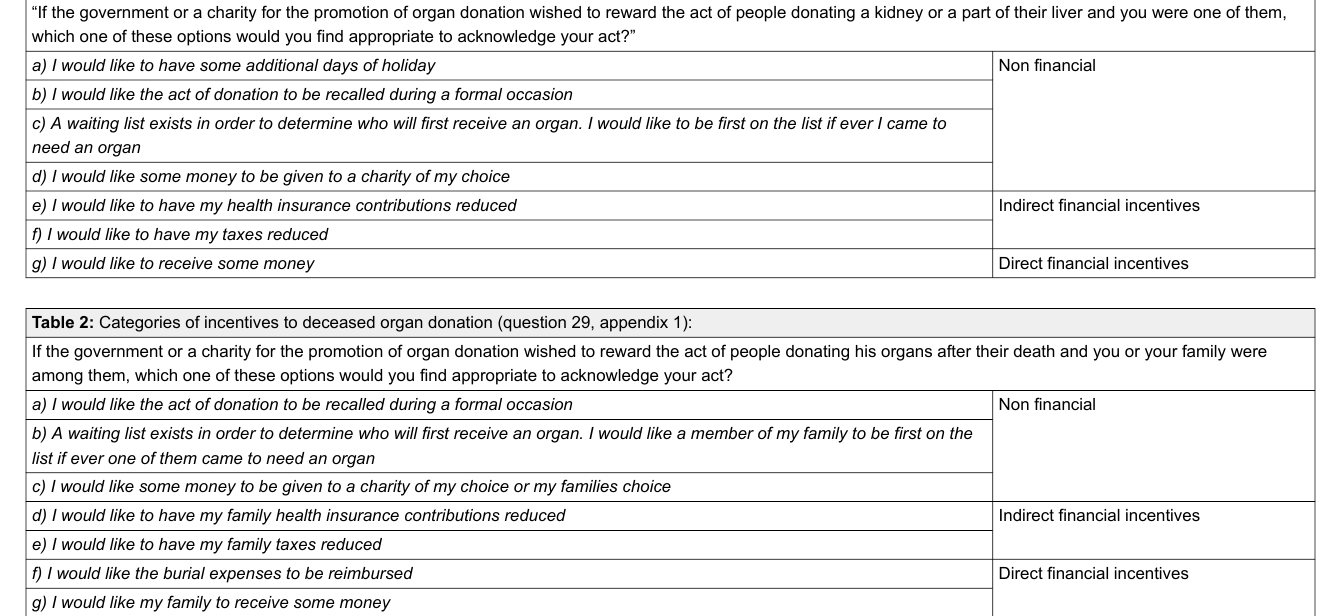
Table 1: Categories of incentives to living organ donation (question 26, appendix 1).